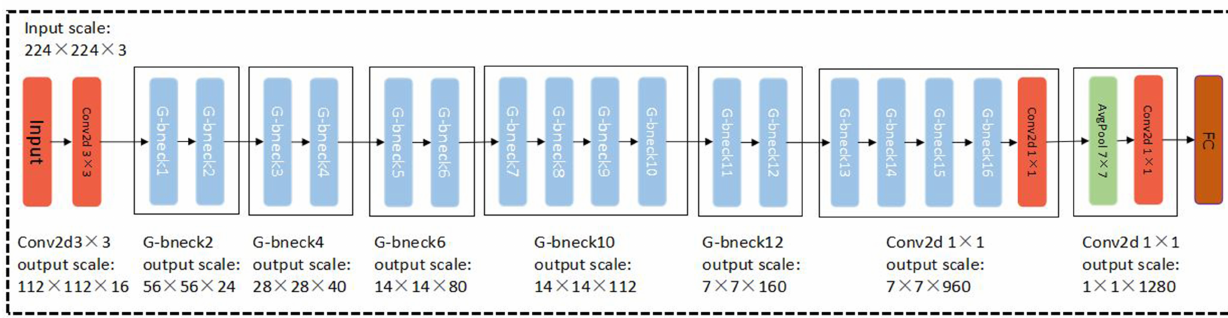
Figure 6. GhostNet network structure. G-bneck represents the Ghost bottleneck.